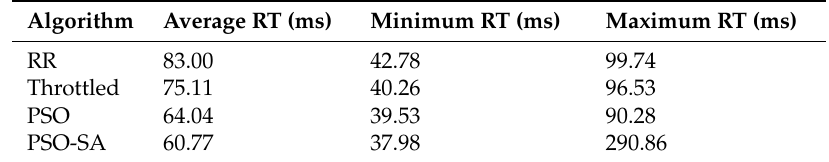
Figure 3. RT of Buildings During 24 h in Scenario 1. Table 1. RT in Scenario